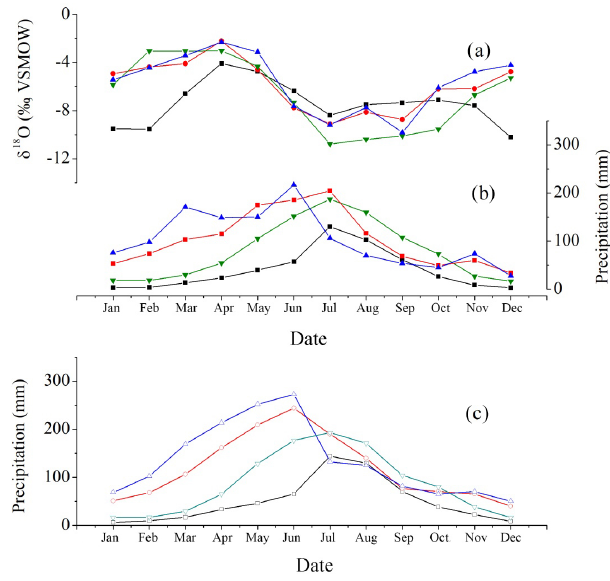
Figure 3. Monthly mean δ 18 O p (a) and precipitation amount (b) data from GNIP stations in northern region of the MRC (black lines), southwestern region of the MRC (green lines), southeastern China (red lines), and the SPR region (blue lines, Changsha station) as grouped in Table 1. (The spatial distribution of the GNIP stations are shown in Fig. 1a.) (c) Monthly mean precipitation data from the meteorological stations closest to the GNIP stations in north- ern region of the MRC (black lines), southwestern region of the MRC (jade lines), southeastern China (red lines), and the SPR re- gion (blue